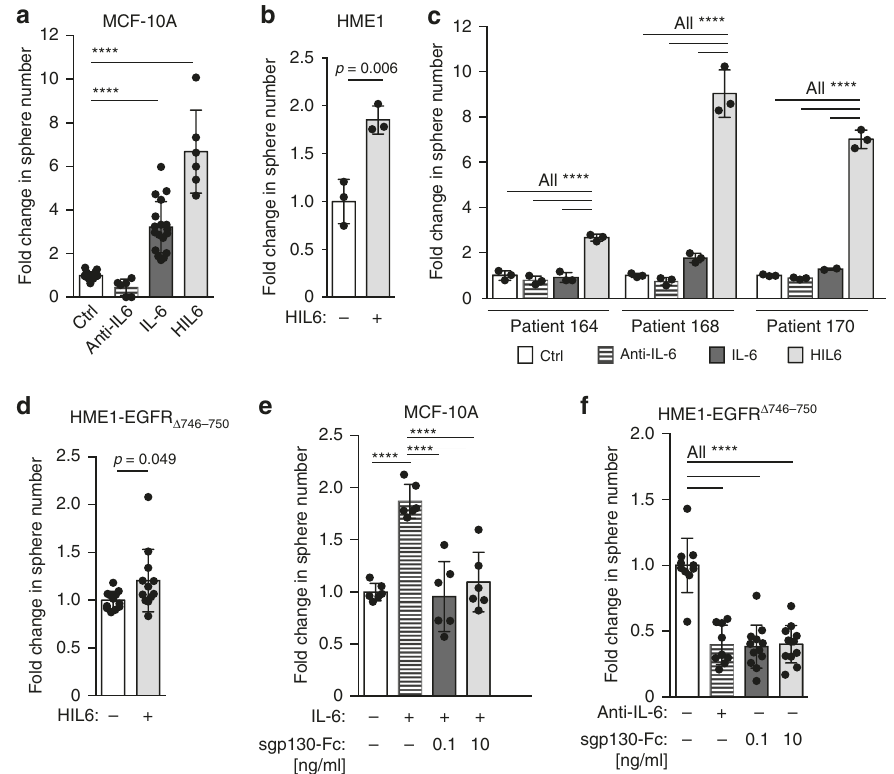
Fig. 4 IL6 trans-signaling regulates sphere-forming ability. a MCF 10A cells were cultured as spheres in the absence ( n = 18) or presence of IL6 ( n = 18), an IL6-blocking antibody ( n = 6) or hyper-IL6 ( n = 6). b hTERT-HME1 were cultured as spheres in the absence ( n = 3) or presence ( n = 3) of hyper-IL6. c HMECs were cultured as spheres without or with IL6, with an IL6 blocking antibody or hyper-IL6. n = 3 patients, each patient analyzed in triplicate. d hTERT-HME1-EGFR Δ 746-750 cells were cultured as spheres in the absence or presence of HIL6 (each n = 12). e MCF 10A cells were cultured as spheres without ( n = 6) or with IL6 ( n = 6) and IL6 plus sgp130-Fc at indicated concentrations (each n = 6). f Sphere formation of hTERT-HME1- EGFR Δ 746-750 in the absence ( n = 10) or presence of an anti-IL6 antibody ( n = 9) or with sgp130-Fc at indicated concentrations (each n = 12). Cumulative data of three experiments. P values in a , c , f : one-way ANOVA with Dunnett ’ s multiple comparisons test (post hoc); b , d two-sided Student ’ s t- test; e one-way ANOVA with Tukey ’ s multiple comparisons test (post hoc); asterisks indicate signi fi cance between groups (**** p < 0.0001). All error bars correspond to standard deviation (Mean ± SD). See Supplementary Table 1 for patient/sample-ID